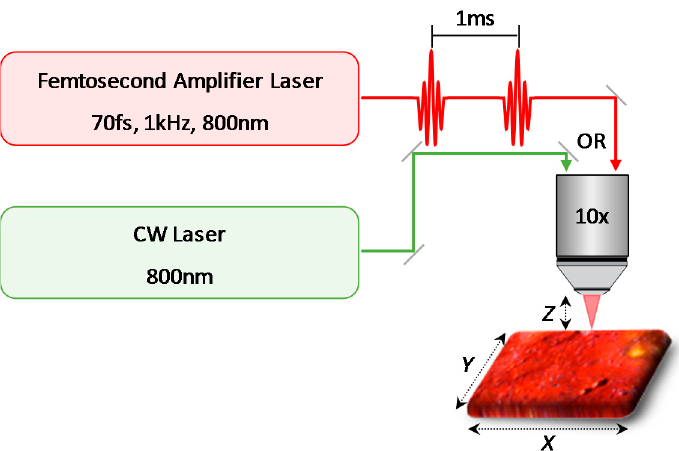
Figure 1. Schematic illustration of the laser cut processing of paints with either a femtosecond or continuous-wave (CW) laser source. The laser beams are focused at each sample through a 10× objective lens. The samples are mounted on a motorized XY translational stage with variable speeds. To completely cut through all the paint layers, the sample is vertically shifted along the Z direction by re-focusing after the completion of each trench.